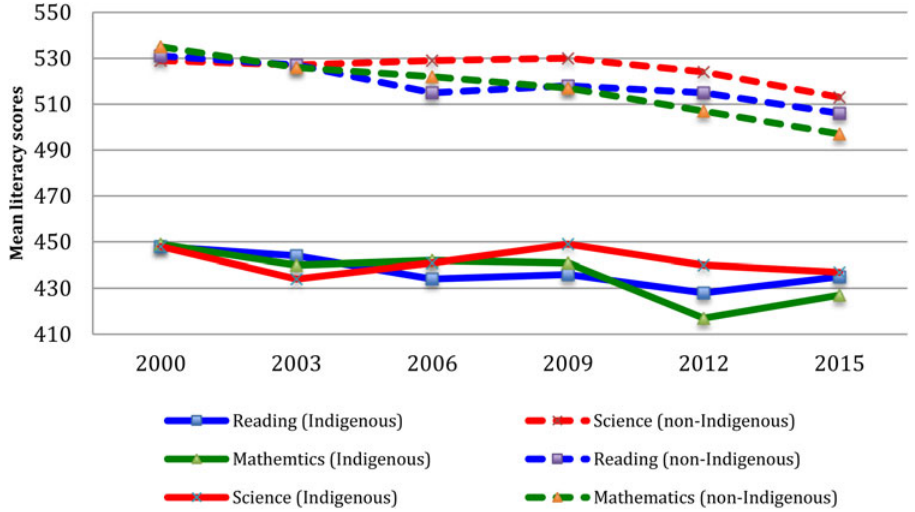
Fig. 1. Indigenous and non-Indigenous PISA results as mean scores 2000 –